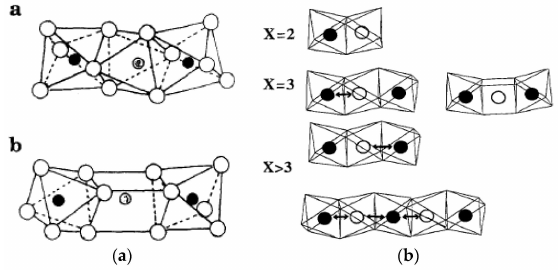
Figure 5. Arrangements of FeO 6 octhedra in trimeric clusters isolated one from the others by P 2 O 7 groups: ( a ) α P 2 O 7 ; ( b ) β Fe 3 P 2 O 7 grey circles: Fe 2+ , filled: Fe 3+ . Electron exchange between iron cations in FeO 6 octahedra clusters calculated by extended Hückel molecular orbital theory. Reproduced from [36]. copyright 2016, Elsevier